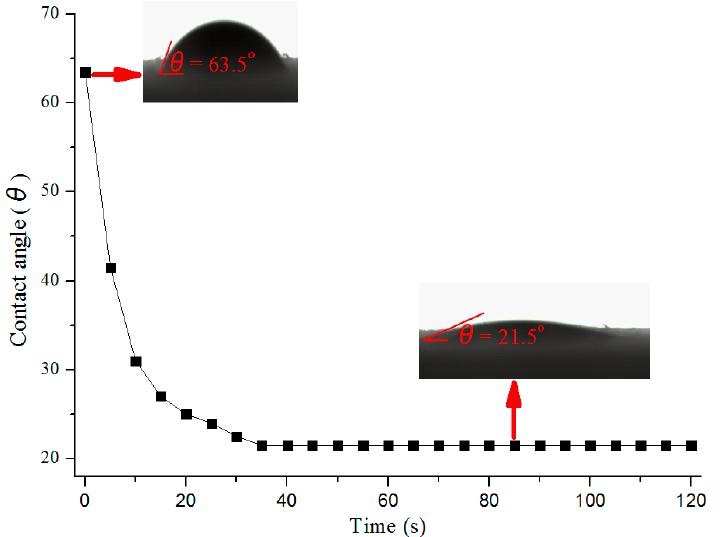
Figure 5. The contact angle of HPFA on pine wood.